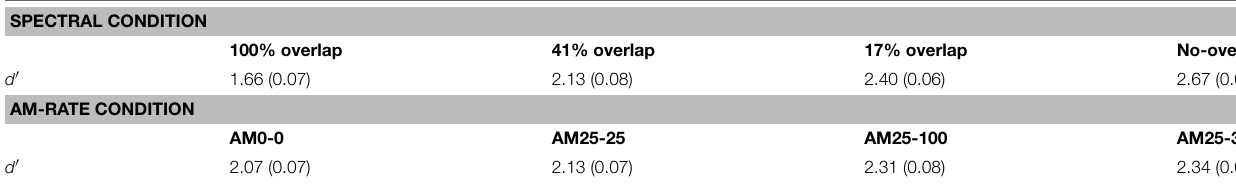
TABLE 2 | Mean d ′ -values in the four spectral conditions for pooled data across AM-rate conditions and mean d ′ -values in the four AM-rate conditions for pooled data across spectral conditions. SPECTRAL CONDITION